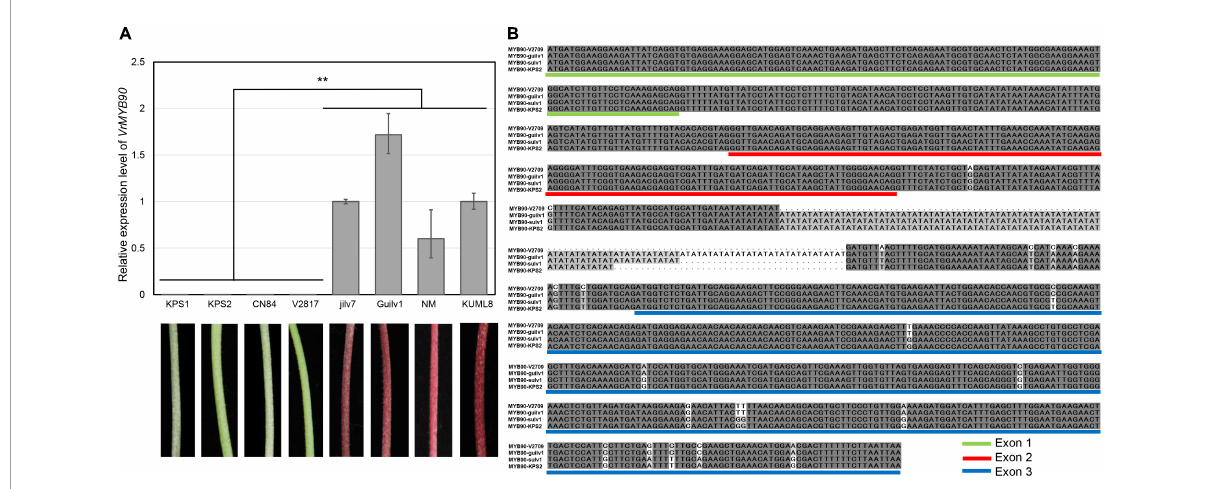
FIGURE3 Expression and sequence analysis of VrMYB90 . (A) Expression of VrMYB90 in eight mungbean accessions; KPS1, CN60, CN84, and V2817 with green hypocotyls Jilv7, V4718, NM, and KUML8 with purple hypocotyls. The expression of VrMYB90 in Jilv7 was set as control. (B) Multiple sequence alignment of VrMYB90 between purple- and green-hypocotyl mungbeans. V2709 and Guilv1 have purple hypocotyls, while Sulv1 and KPS2 have green hypocotyls. Exons are identified by colored underlines. **Indicates a significant difference by Student’s t- test ( P < 0.01).